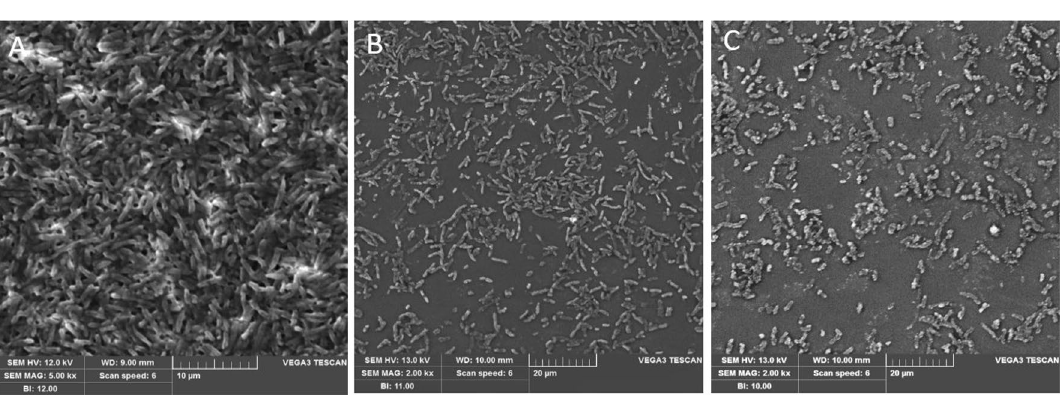
Figure 5. Scanning electron microscopy images of S. marcescens biofilm. ( A ) Control shows biofilm formation after 24 h of incubation. ( B,C ) Quercetin inhibited the biofilm formation at a concentration of ¼ MIC and ½